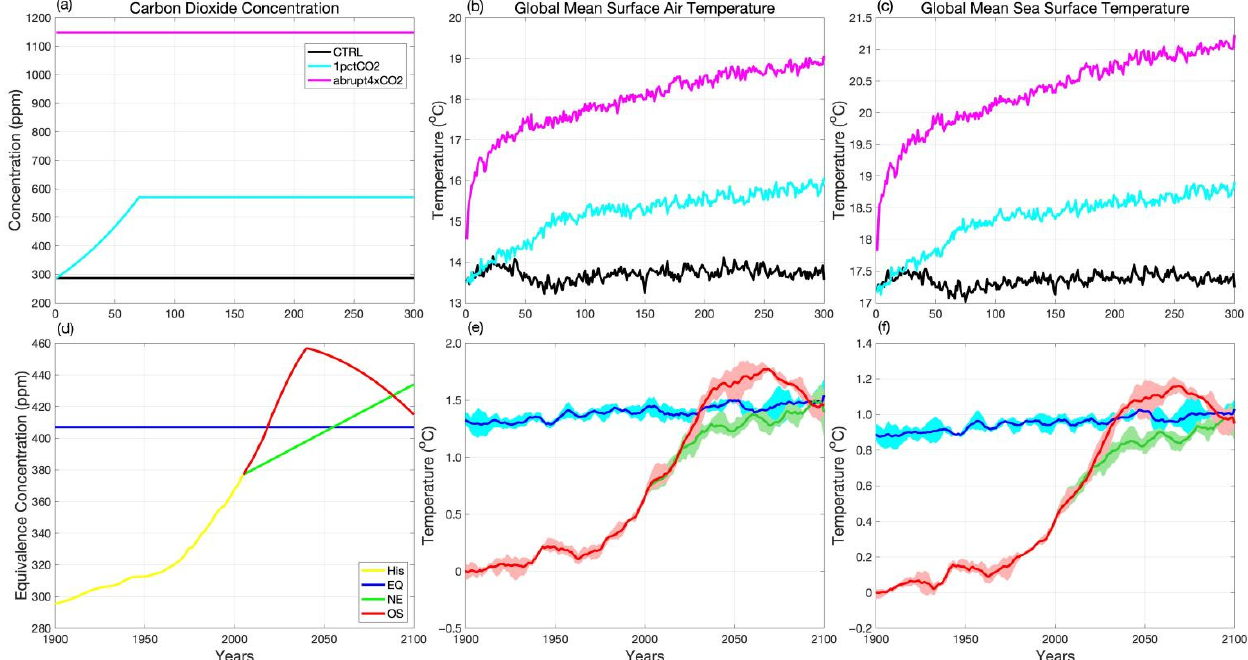
Figure 1. The time series of the CO 2 concentration ( a , d ), global mean surface air temperature ( b , e ), and global mean sea surface temperature ( c , f ). The black line represents the control run (CTRL). The light blue and green lines represent the 1% per year CO 2 increase experiment (1 pctCO 2 ) and the abrupt quadrupling of CO 2 experiment (abrupt4×CO 2 ), respectively. The yellow line represents the historical CO 2 concentration (His). The blue, green, and red lines represent the average of the equilibrium experiment (EQ), the never-exceed pathway (NE), and the overshoot pathway of 1.5 °C (OS), respectively. The shaded region in ( e , f ) is calculated from three members of each experiment.